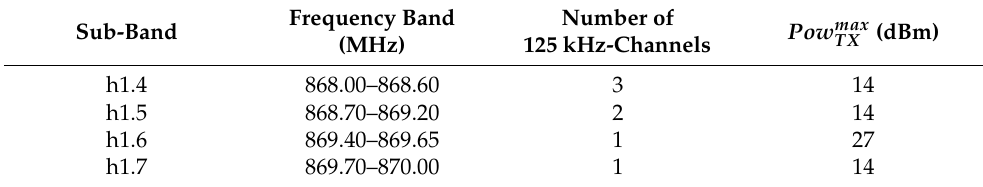
Table 3. Sub-bands of the EU868 ISM Band that match the ERC Recommendation 70-03. Sub-Band